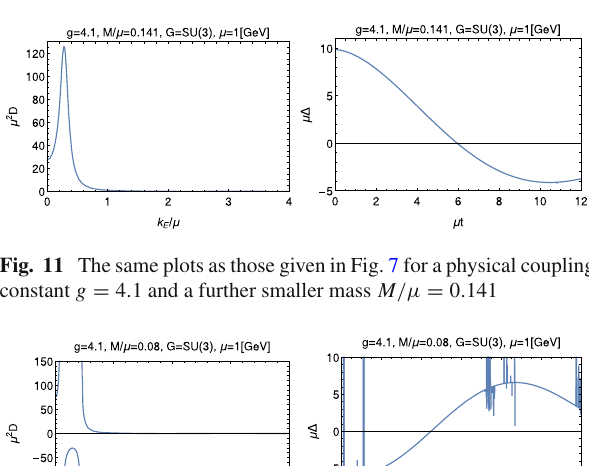
plot of min 0 < t < ∞ (cid:6)( t )/(cid:6)( t = 0 ) on the two-dimensional 2 C 2 ( G ) , λ )=( M 2 , g ). Figure 14 gives the parameter plane ( M 2 μ 2 μ 2 16 π 2 same plot with larger range of parameters. Note that the left- (cid:15) 1 , λ (cid:14) 1 ) and right-upper ( M 2 (cid:14) 1 , λ (cid:14) 1 ) upper ( M 2 μ 2 μ 2